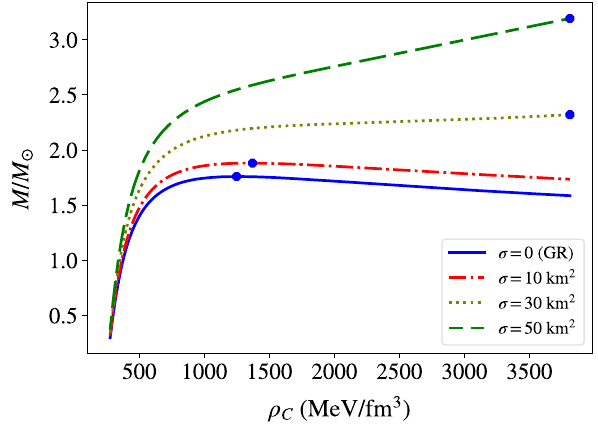
Fig. 2 Mass-central energy density relation of quark stars for different values of